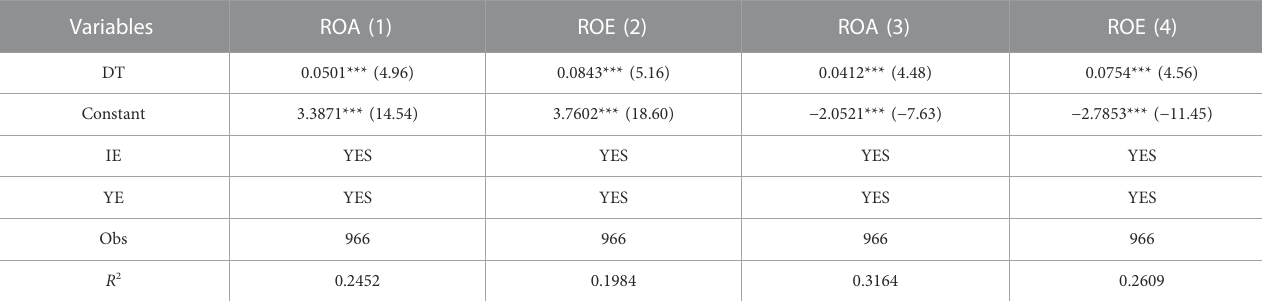
TABLE 2 Baseline results.